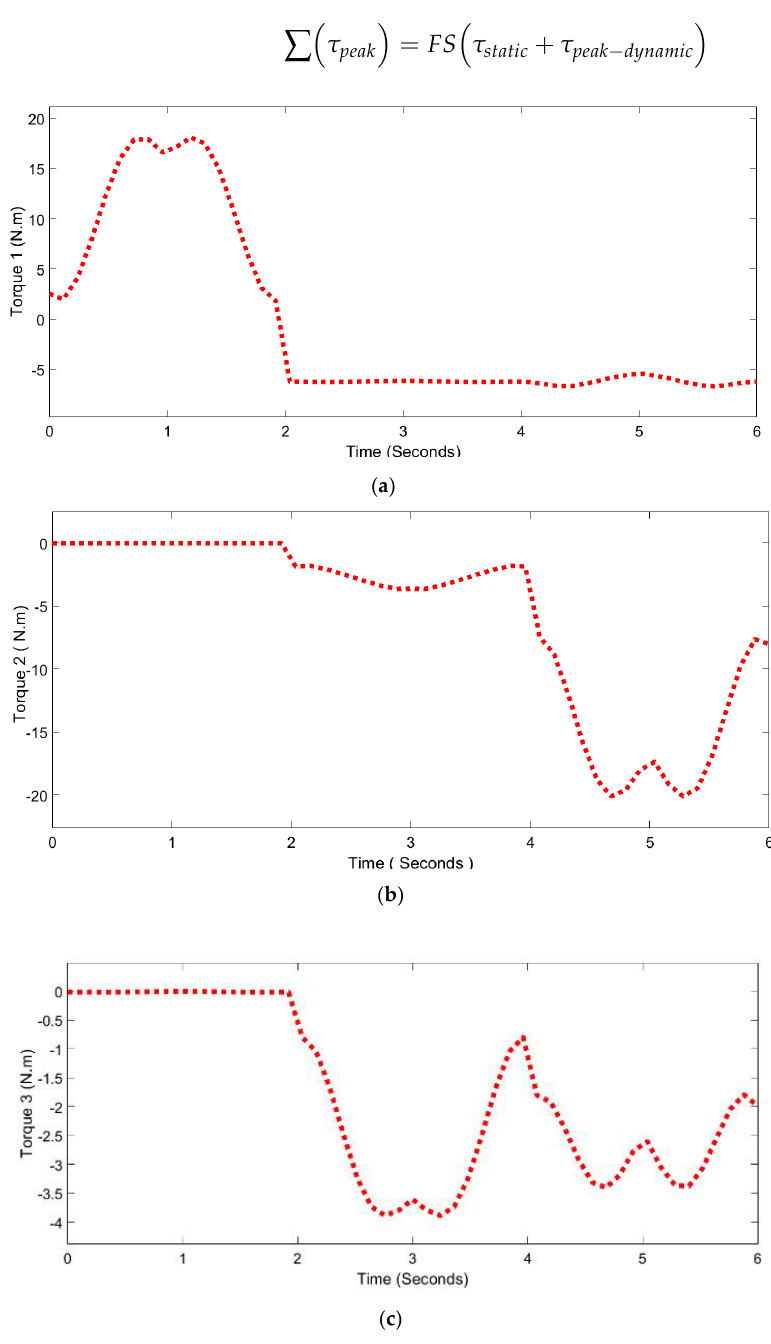
Figure 12. Simulation results: ( a ) shoulder abduction/adduction rotation output torque, ( b ) shoulder flexion/extension rotation output torque and ( c ) elbow flexion/extension rotation output torque. Table 5. Motor sizing for the joints of the SAMA exoskeleton.